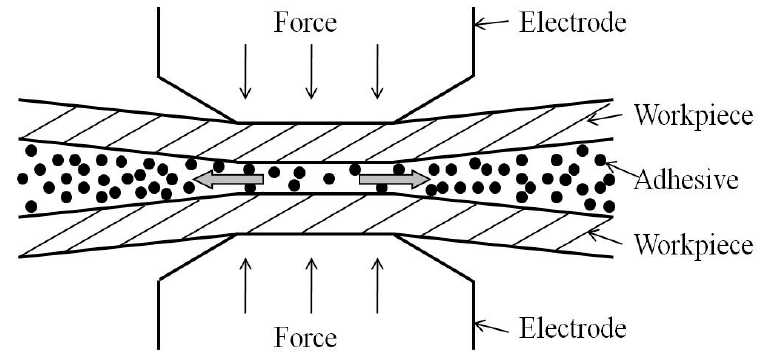
Figure 7. Diagram of adhesive flowing between steel sheets in the squeeze cycle.